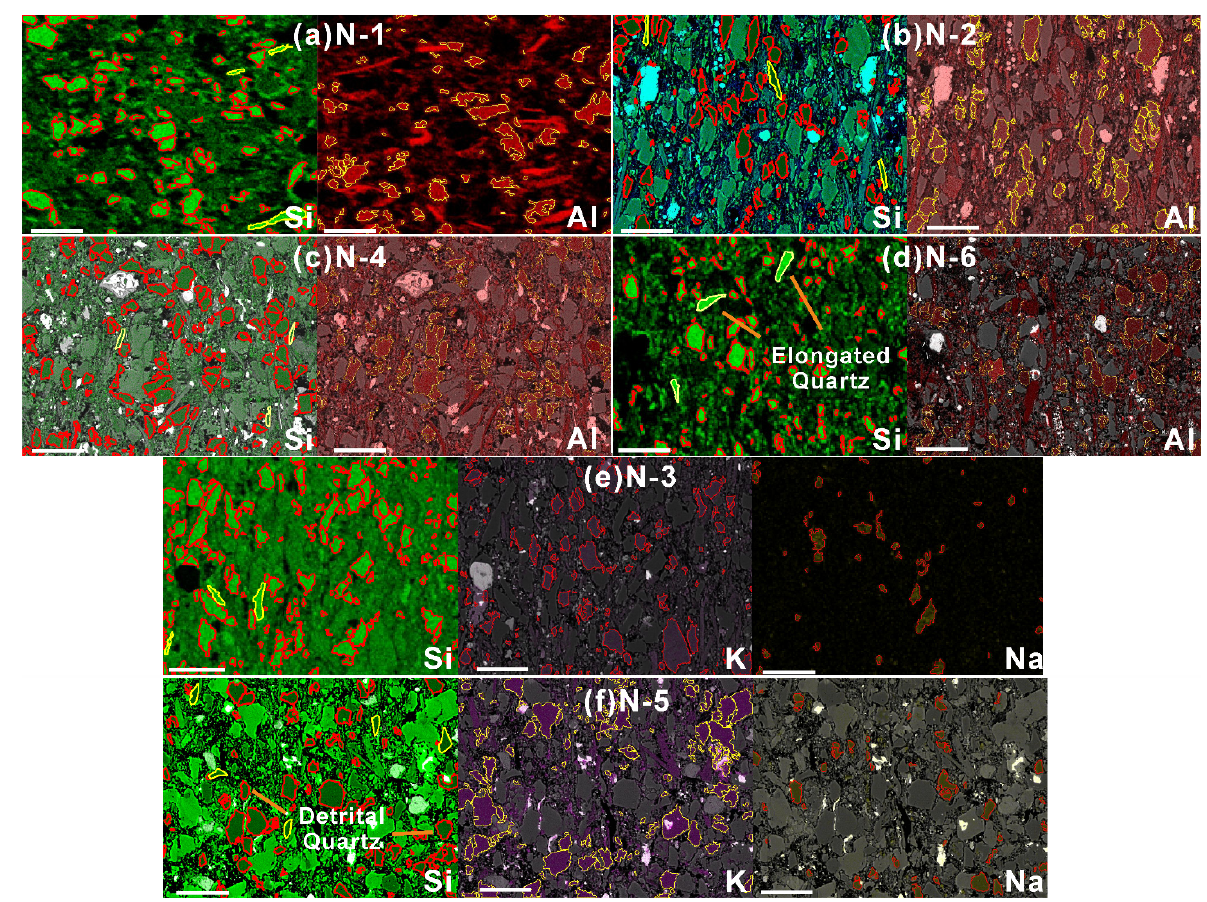
Figure 9. EDX maps (Si, Al, K, and Na) collected from Niutitang samples. ( a – f ) EDX maps of N-1, N-2, N-4, N-6, N-3 and N-5, respectively. Yellow outlines in the Si maps mark “elongated” quartz. The scales are 50 μ m.